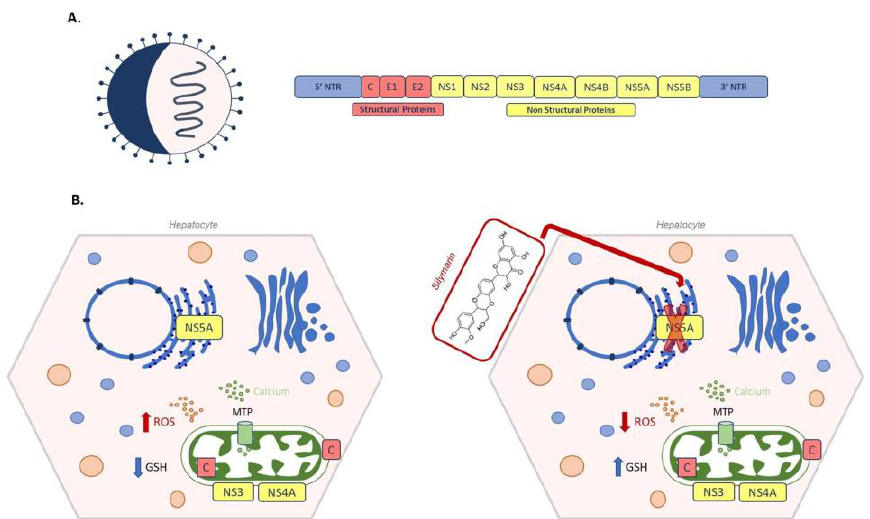
Figure 8. Schematic representation of hepatitis C virus (HCV) and silymarin treatment. ( A ) On the left a viral particle of HCV, on the right a HCV genome, with structural (Core, Envelope 1 and Envelope (2) and non-structural proteins (NS1, NS2, NS3, NS4A, NS4B, NS5A and NS5B). ( B ) On the left, an example of oxidative stress caused by viral proteins: core protein C binds to the inner and to the outer mitochondrial membrane; viral NS3/NS4 complex is associated with the outer mitochondrial membrane, while NS5A localizes on the endoplasmic reticulum. Viral NS5A increases calcium release from the ER into the cytoplasm. Through mitochondrial transition pore (MTP), calcium enters into the mitochondria, enhancing ROS production, together with C and NS3/NS4 proteins. On the right, silymarin administration blocks NS5A polymerase activity, ROS decreases and GSH levels increase.